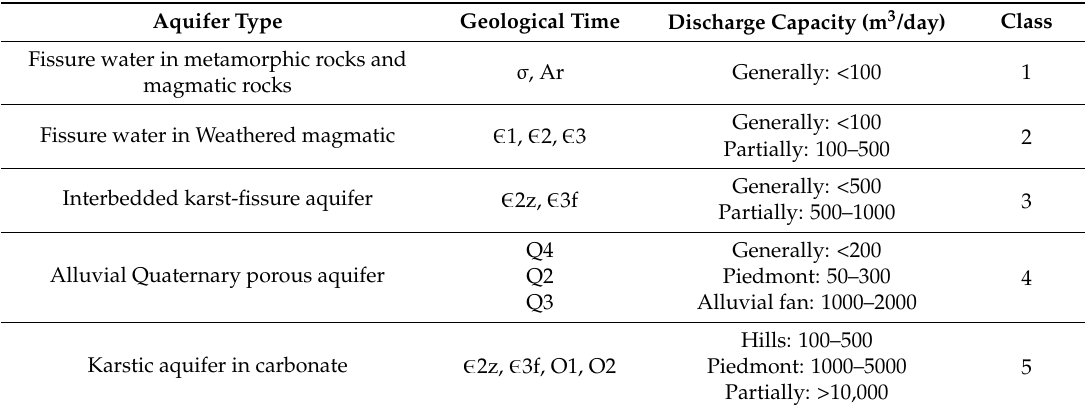
Table 3. Hydraulic characteristics and classification of aquifer in Jinan City.